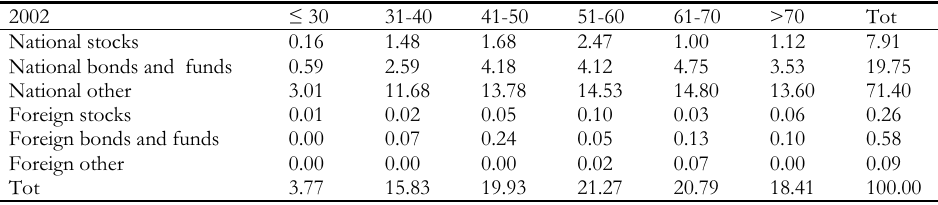
Italian households financial wealth by age of the head of the household, 2002 , percentages National stocks